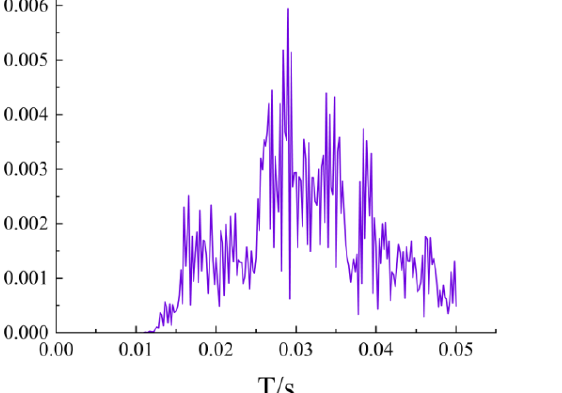
Figure 8. Vibration velocity curve of right arch shoulder of reinforced concrete tunnel.